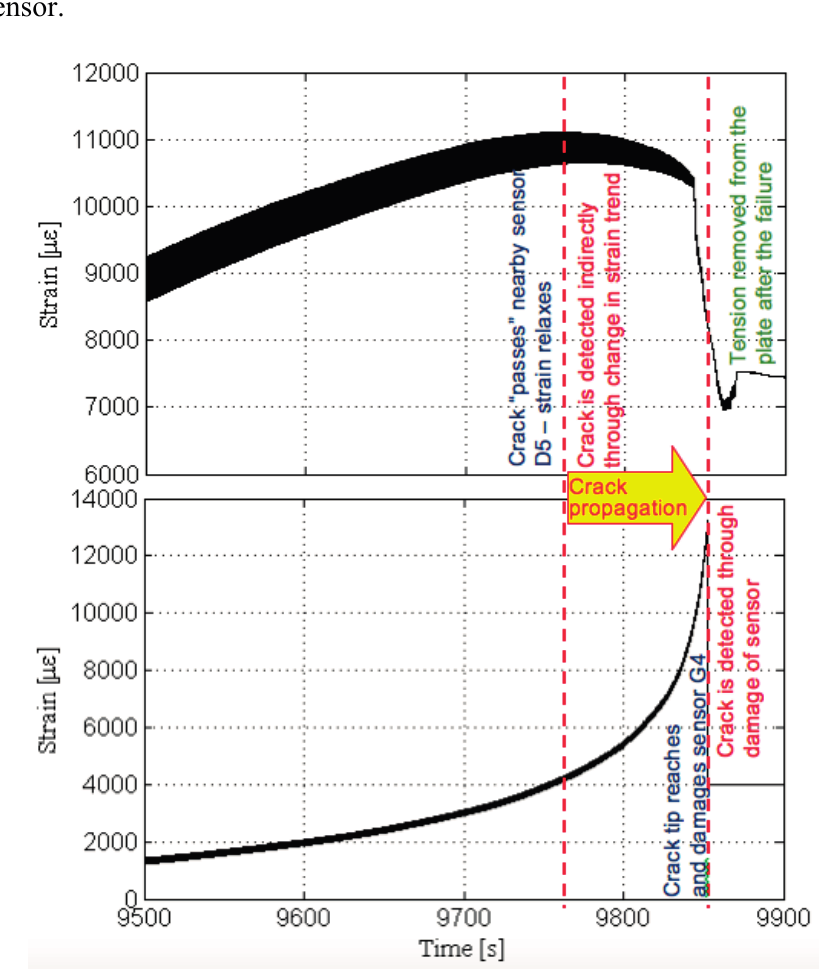
Figure 17. Propagation of crack from location “D” to location